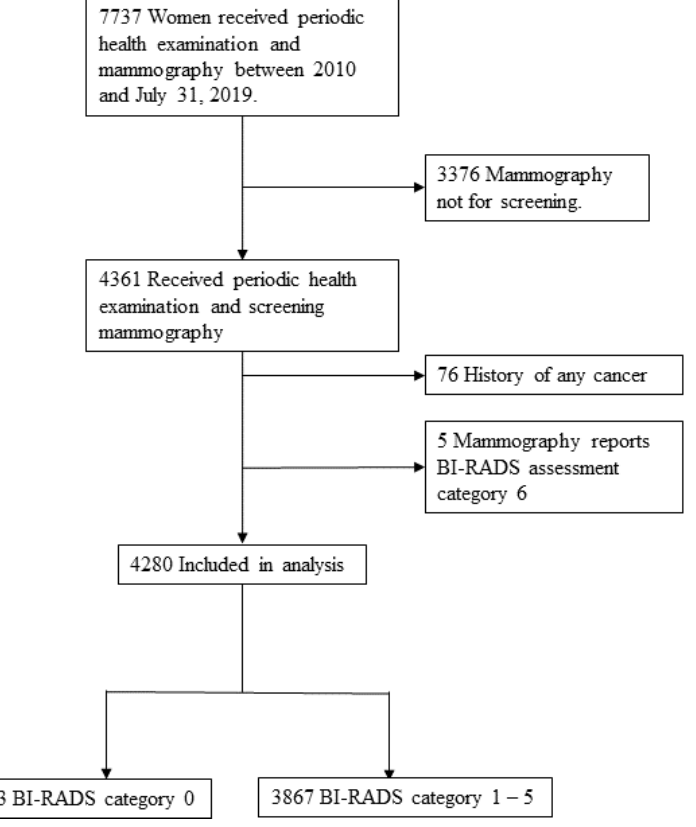
Figure 1. The flowchart of the study selection process.